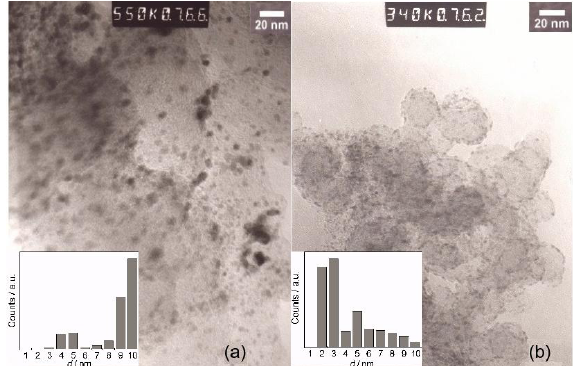
Figure 2. TEM micrographs of Pd/C (a) and Pt/C